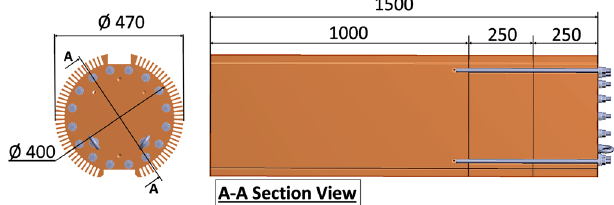
model of the new CuCr1Zr PSB dump core. Dimensions are reported in mm.